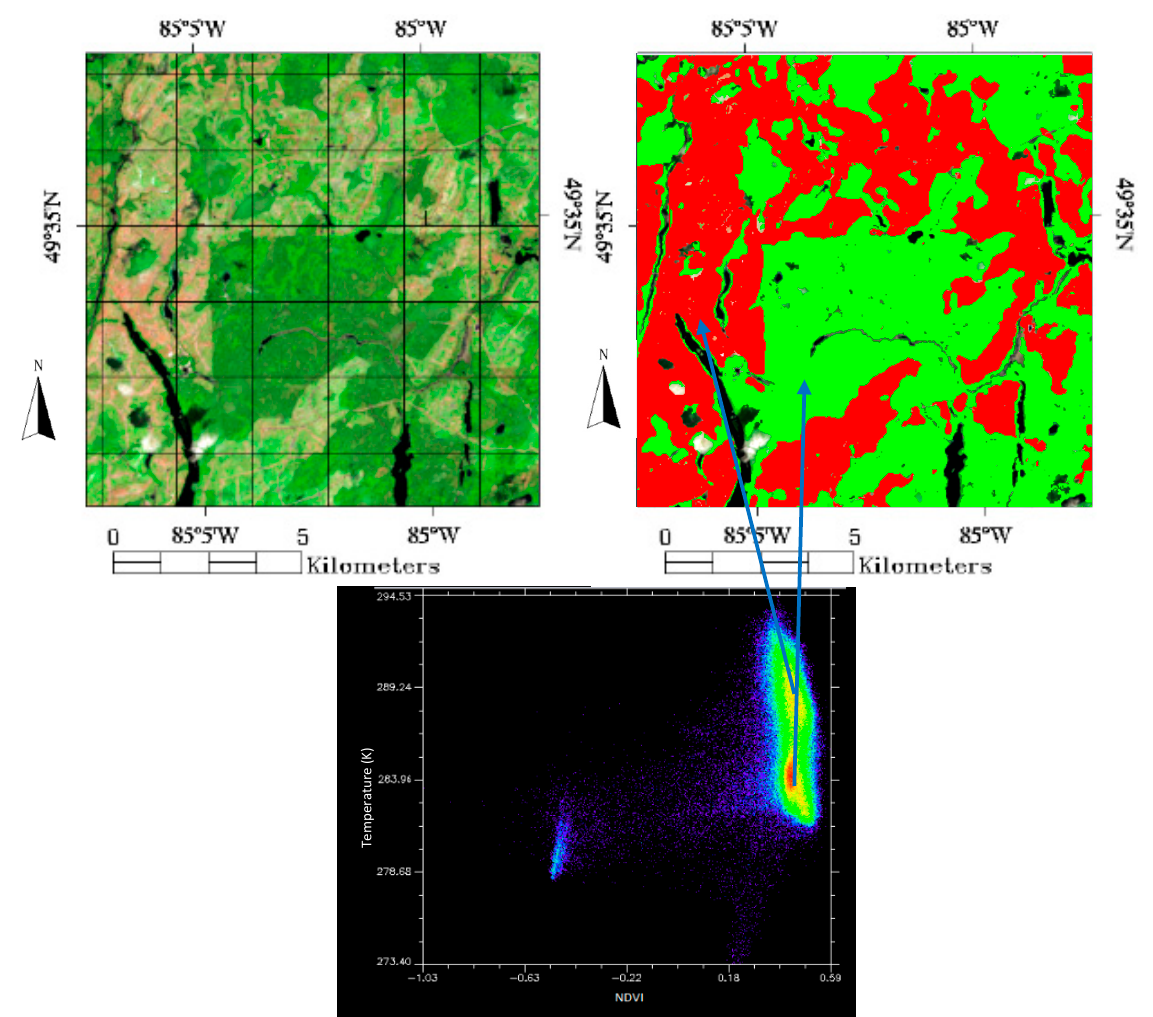
Figure 3. Top left: true color image of test area. Bottom: scatter plot of surface temperature versus NDVI. Top Right: Classified image based on the two main clusters produced from the bottom image. Classes are cleared areas (red) and grassy areas with small plants (green).